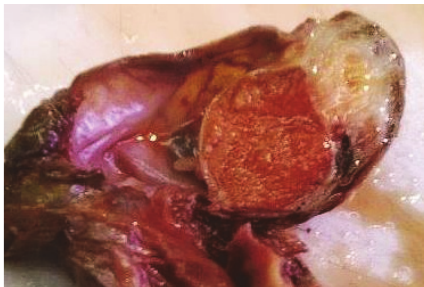
Figure 1: Well-limited solidocystic paratesticular tumor.